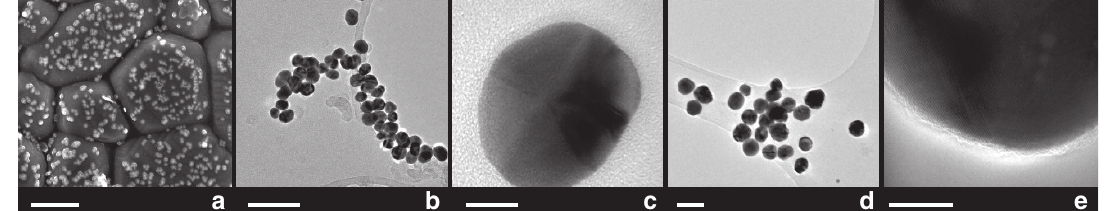
Figure 1 | Electron microscopy of substrate and particles. ( a ) AuNPs on TiO 2 ( b , c ) AuNPs, ( d , e ) AgNPs. Scale bars given are 500nm ( a ), 100nm ( b , d ) and 10nm ( c , e